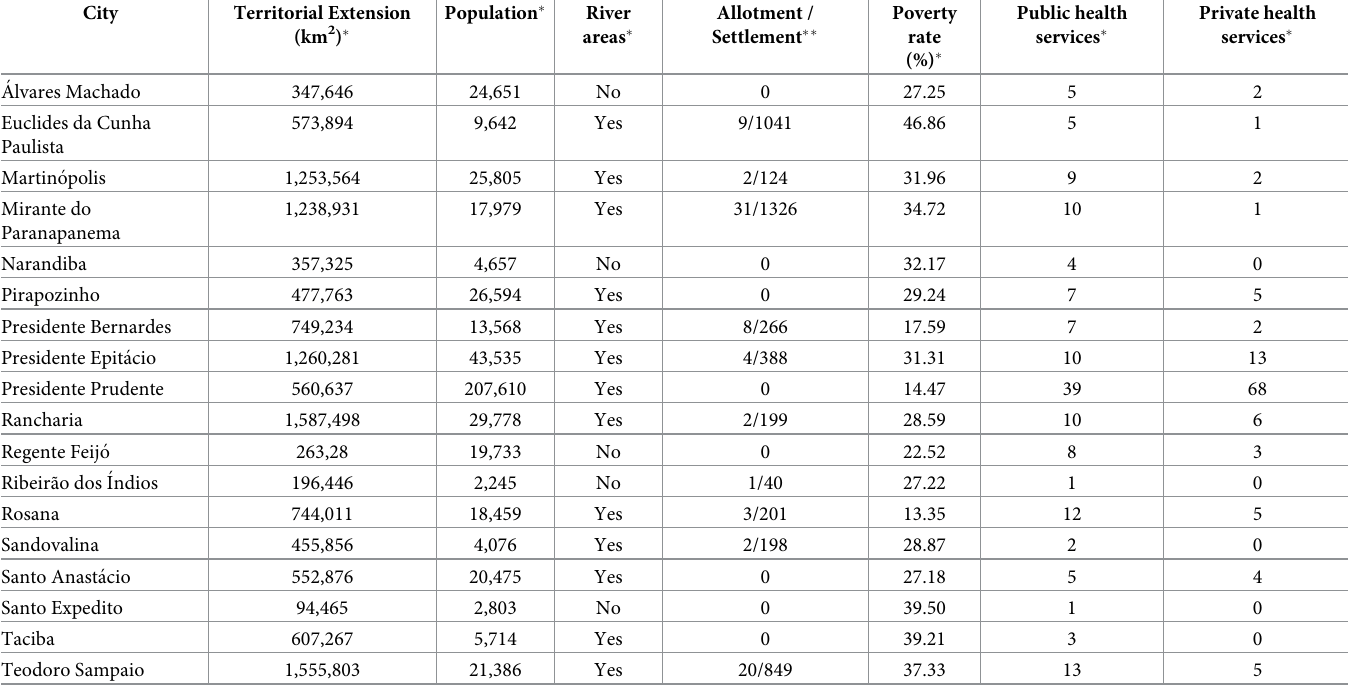
Table 1. Variables related to cities where cases of gestational syphilis (GS) and mother-to-child transmission (MTCT) of syphilis were notified. A´lvares Machado, Narandiba, Pirapozinho, Presidente Prudente, Regente Feijo, Santo Anasta´cio Santo Expedito and Taciba did not present rural settlements. No statistics correlation was found between poverty index or the nature of the health service with the incidence of reported cases. Databases: � Brazilian Institute of Geography and Statistics—IBGE (2010); �� Institute of Lands of S ã o Paulo state–ITESP (2017). City